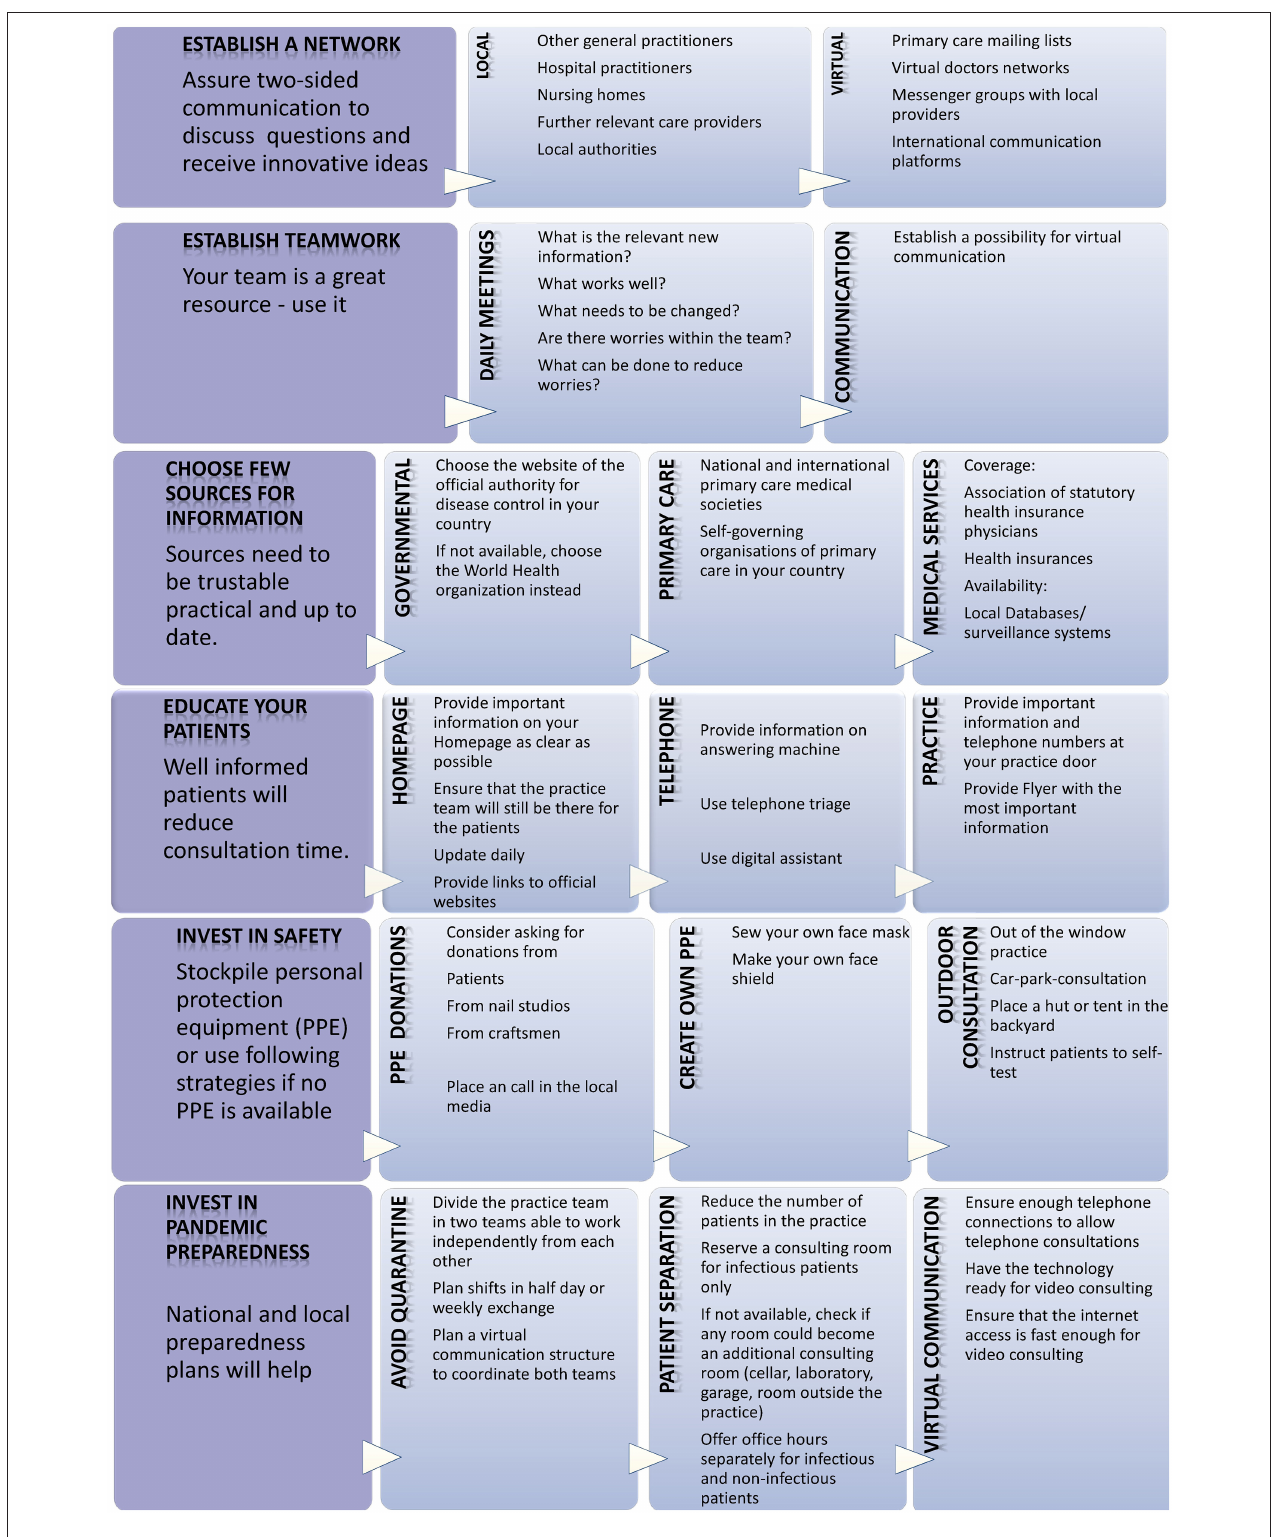
FIGURE 2 | Strategies to face a pandemic in primary care.